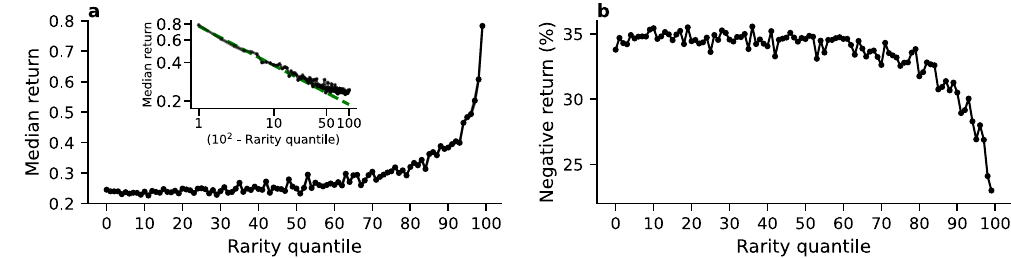
Figure 7. High rarity leads to higher returns, and a lower chance of a negative return. ( a ) Median return in USD by rarity quantile. Inset: median return against the quantity (100- q ), where q is the rarity quantile in log- log scale (black line) and the corresponding power law fit (green dashed line). ( b ) Fraction of sales with negative return in USD by rarity